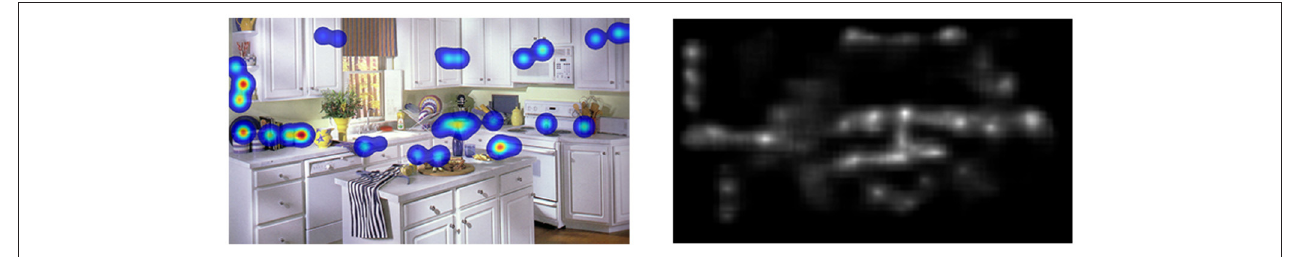
FIGURE 2 | Example image with a heatmap for the reference, and resulting salience map. Our proposed SLCA accepts the salience map as input and is agnostic of the algorithm used to produce that